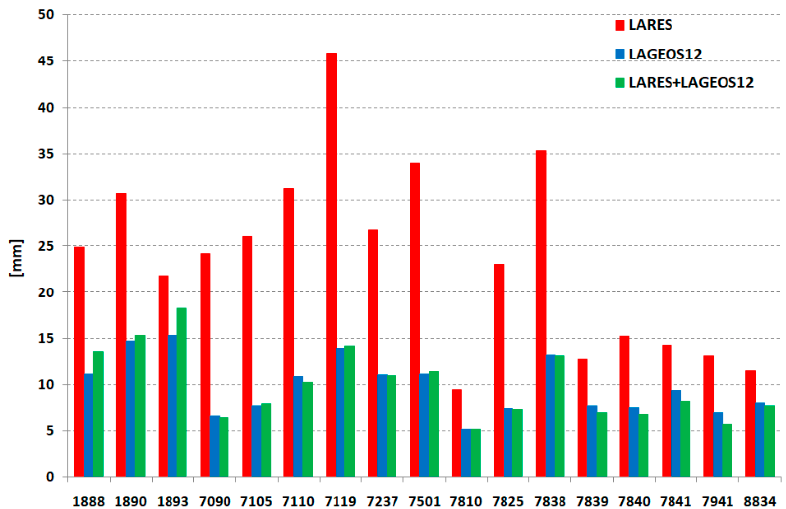
Figure 7. 3DRMS for each station for the three solutions: only LARES (red), LAGEOS-1 + LAGEOS-2 (blue), LARES + LAGEOS-1 + LAGEOS-2 (green).